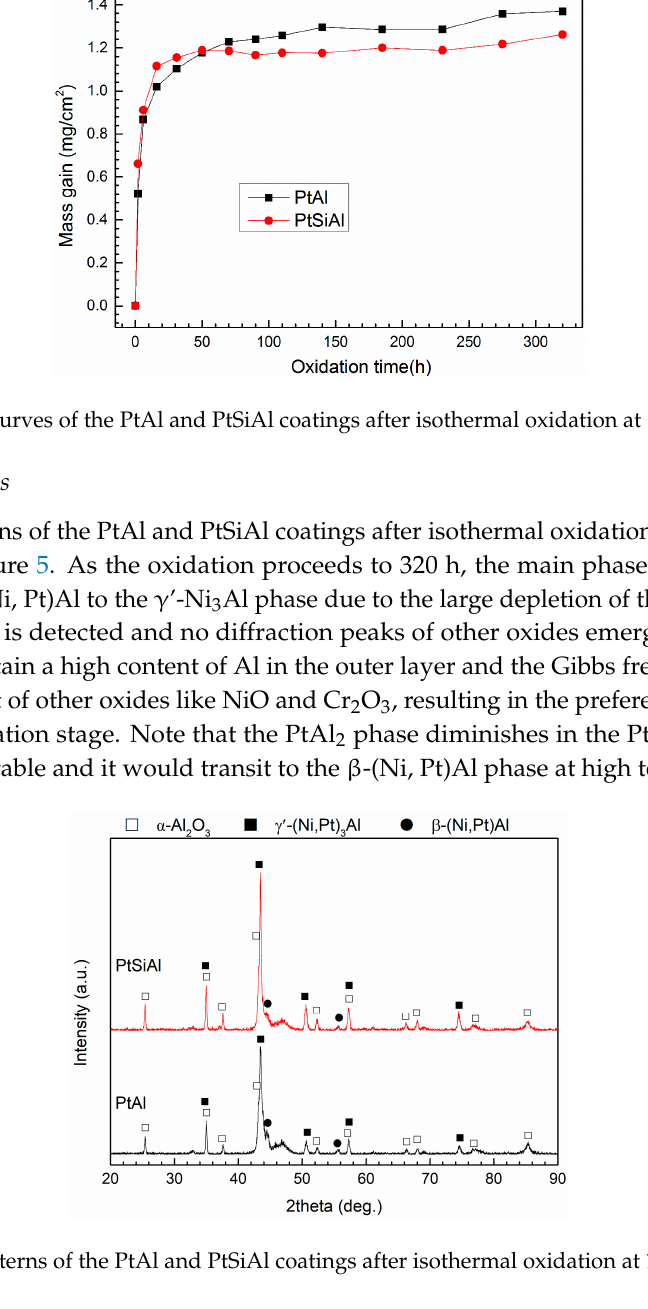
Figure 5. XRD patterns of the PtAl and PtSiAl coatings after isothermal oxidation at 1100 °C for 320 h.